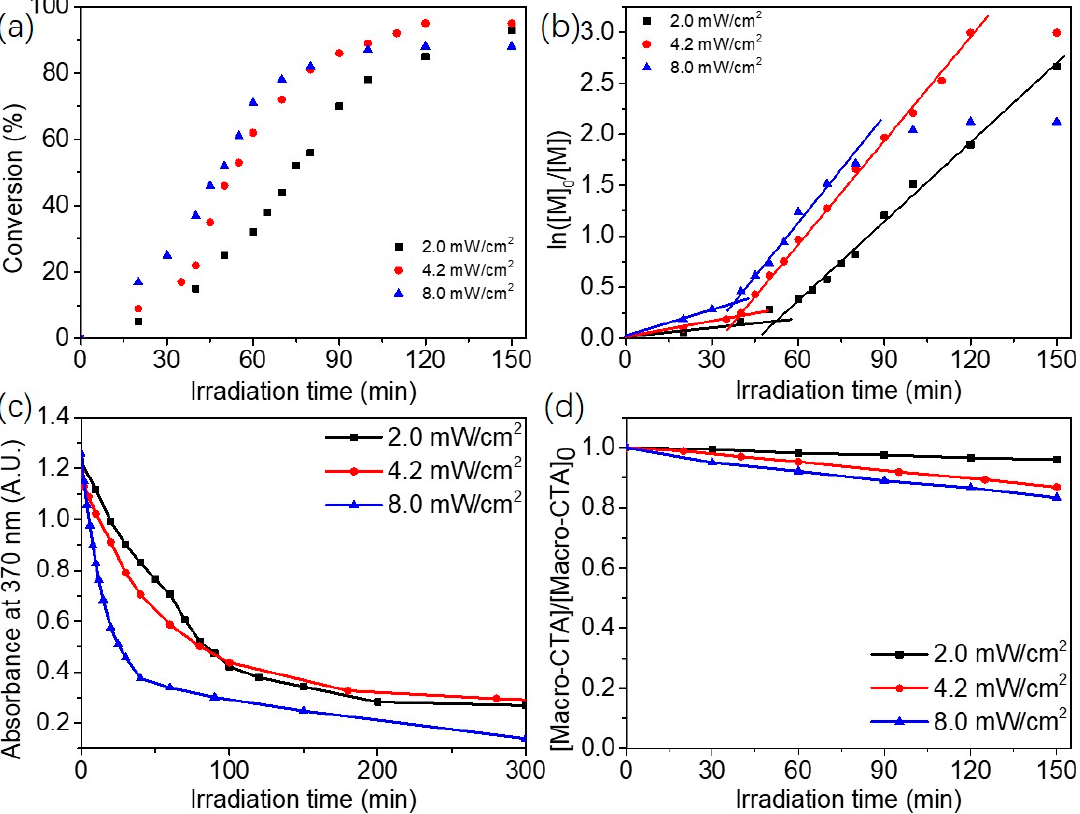
Figure 2. ( a ) Polymerization kinetics for blue light-initiated alcoholic RAFT dispersion polymerization of mPEG 45 -PBzMA 100 (20% w / w BzMA) at different light intensities. ( b ) Plots of ln ([M] 0 /[M]) versus irradiation time for blue light-initiated alcoholic RAFT dispersion polymerization of mPEG 45 -PBzMA 100 (20% w / w BzMA) at different light intensities. ( c ) Plots of normalized absorbance (at 370 nm) of BAPO vs. irradiation time under 465 nm visible-light irradiation. ( d ) Degradation of mPEG 45 -CDPA under blue light irradiation as measured by UV–Vis spectroscopy at different light intensities.